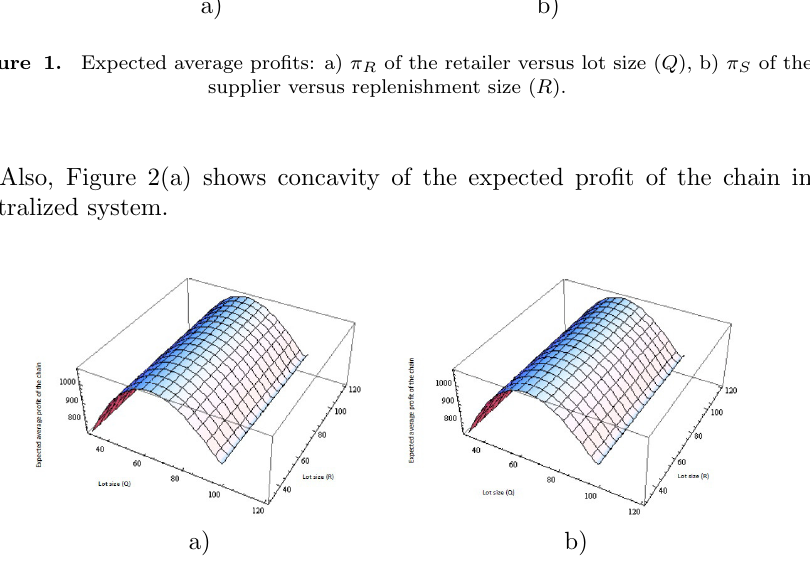
Figure 2. Expected average profits: a) π c of collaborating system versus lot size ( Q ) and replenishment size ( R ) in case of normal distribution, b) ( π c ) of collaborating system versus lot size ( Q ) and replenishment size ( R ) in case of distribution